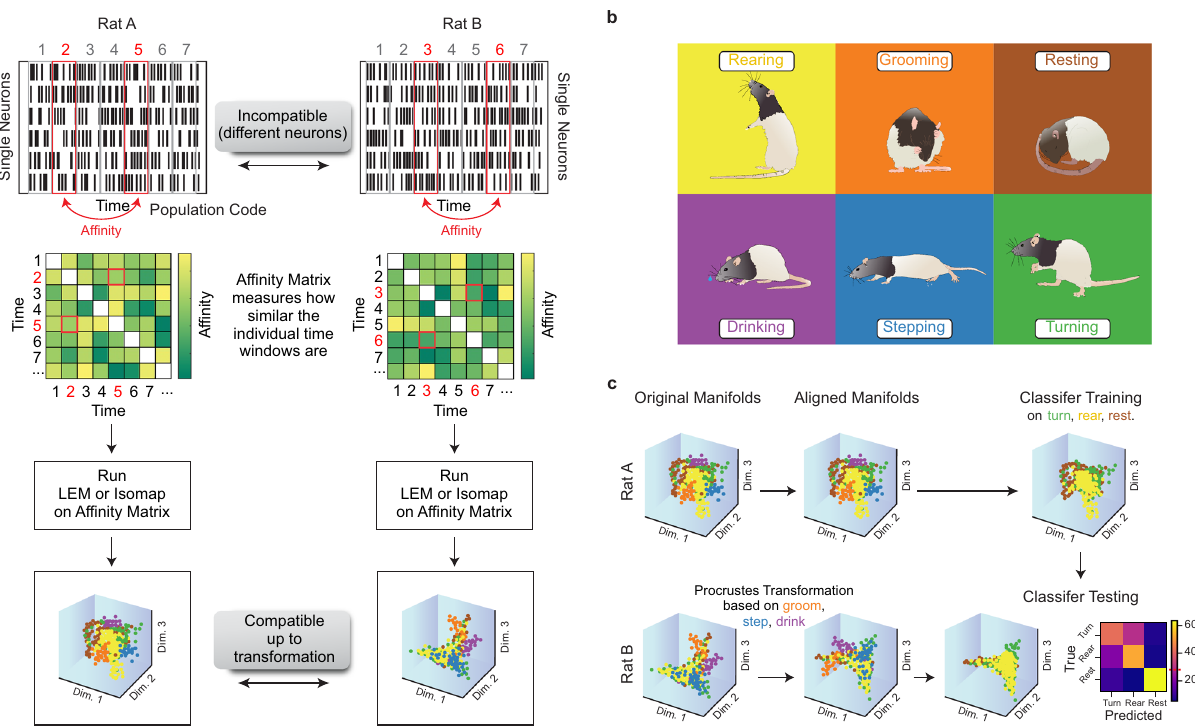
Fig. 4 | Alignment procedure of neural structures for cross-subject general- ization.a Neuronalactivityonthesingle-neuronlevelisnotcomparableacrossrats and sessions. To reveal population structures that are compatible — up to a trans- formation — acrosssubjects,wecomputedtheaf fi nitiesofthepopulationactivityat different time points. The resulting af fi nity matrices could then be used for dimensionality reduction. b This represents the different classes of behavior exhibited by the rats.Ratdrawings adapted from SciDraw (https://doi.org/10.5281/ zenodo.3926077, https://doi.org/10.5281/zenodo.3926015, https://doi.org/10.